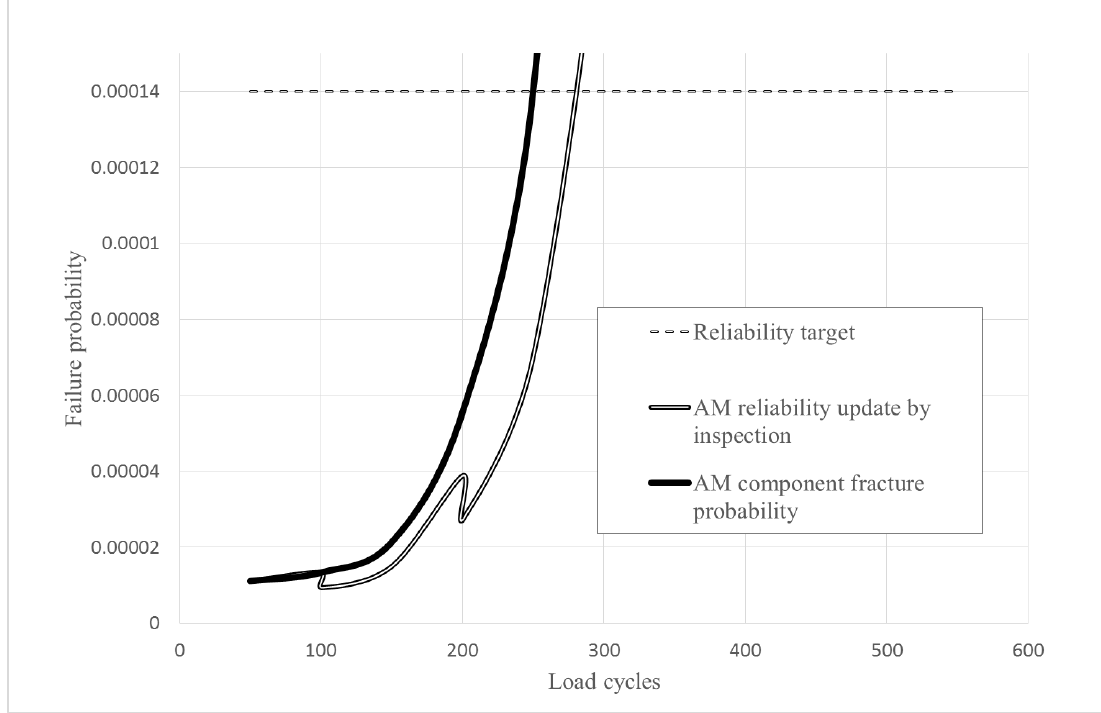
Figure 7. AM-Case failure probability with inspection.